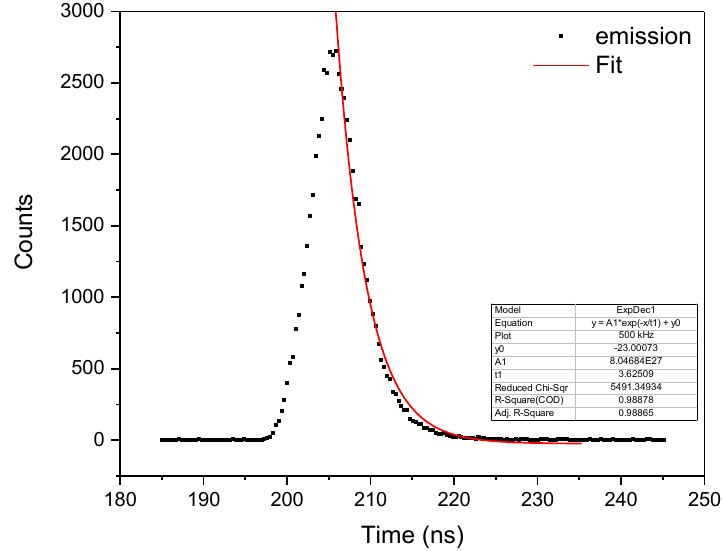
Figure 5. Emission spectra in the solid state of GlySalX in air and after degassing ( λ Ex = 337 nm).